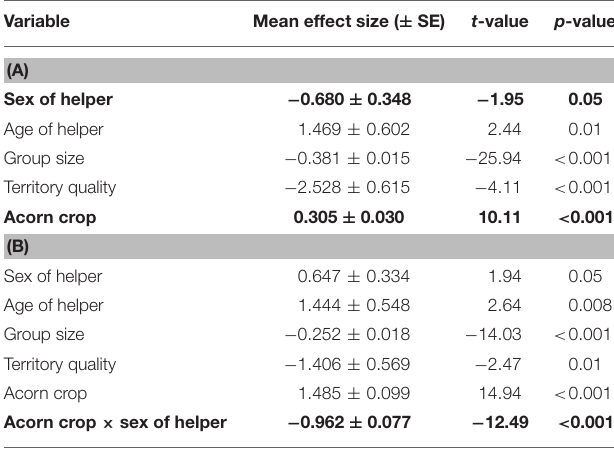
TABLE 5 | Generalized linear mixed-effects model of the proportion of time helpers spend in the vicinity of their home territory (A) without the interaction between the size of the acorn crop and sex of the helper and (B) including this